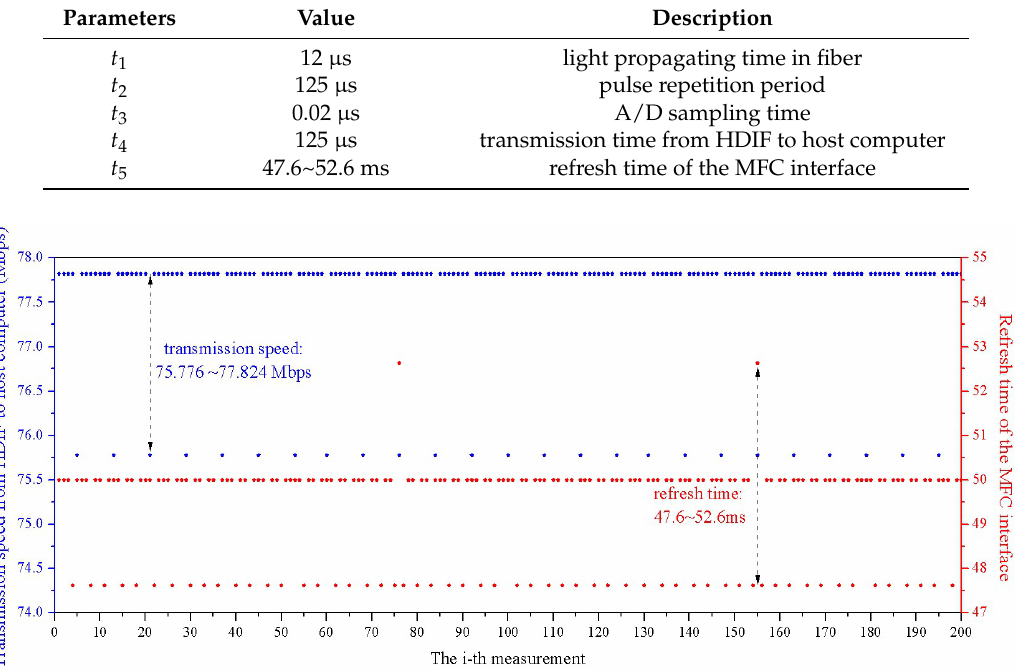
Figure 5. Experimental tests of the transmission speed and refresh time of the MFC interface.